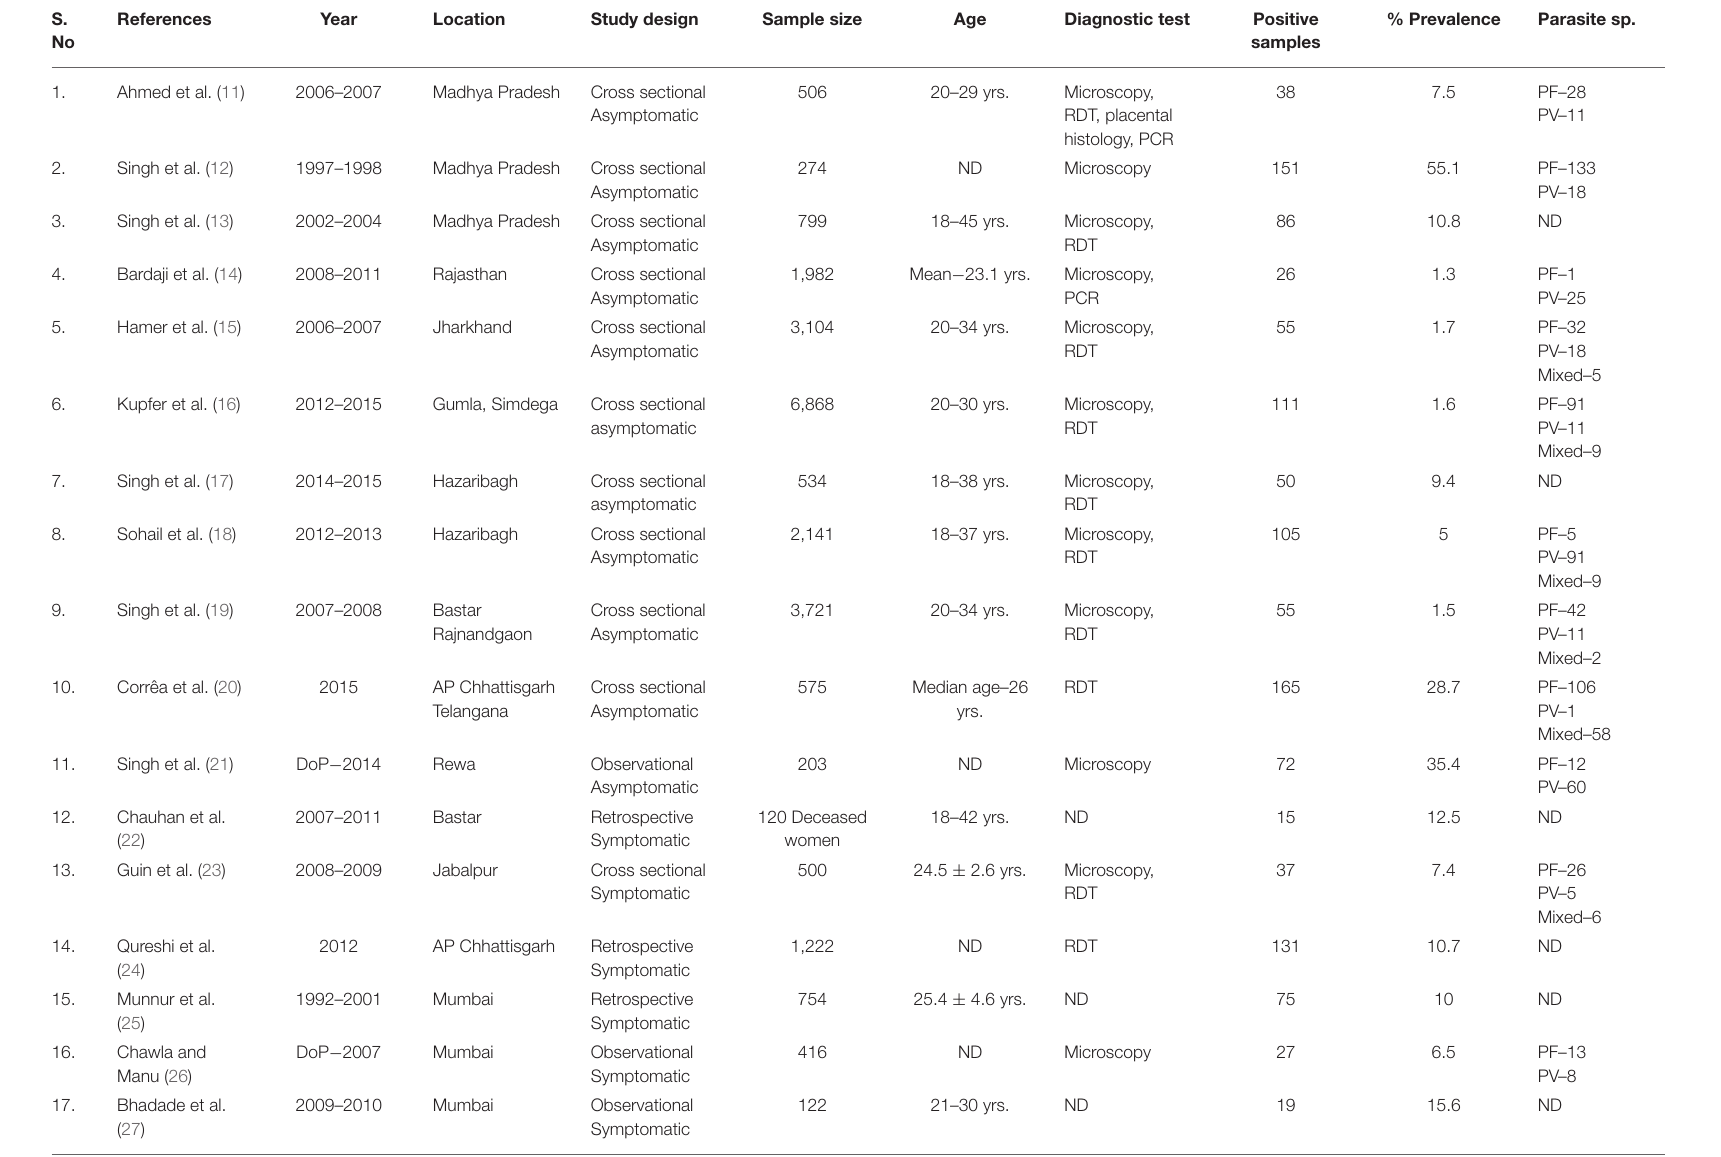
TABLE 2 | Overview of the extracted data considered for the systematic